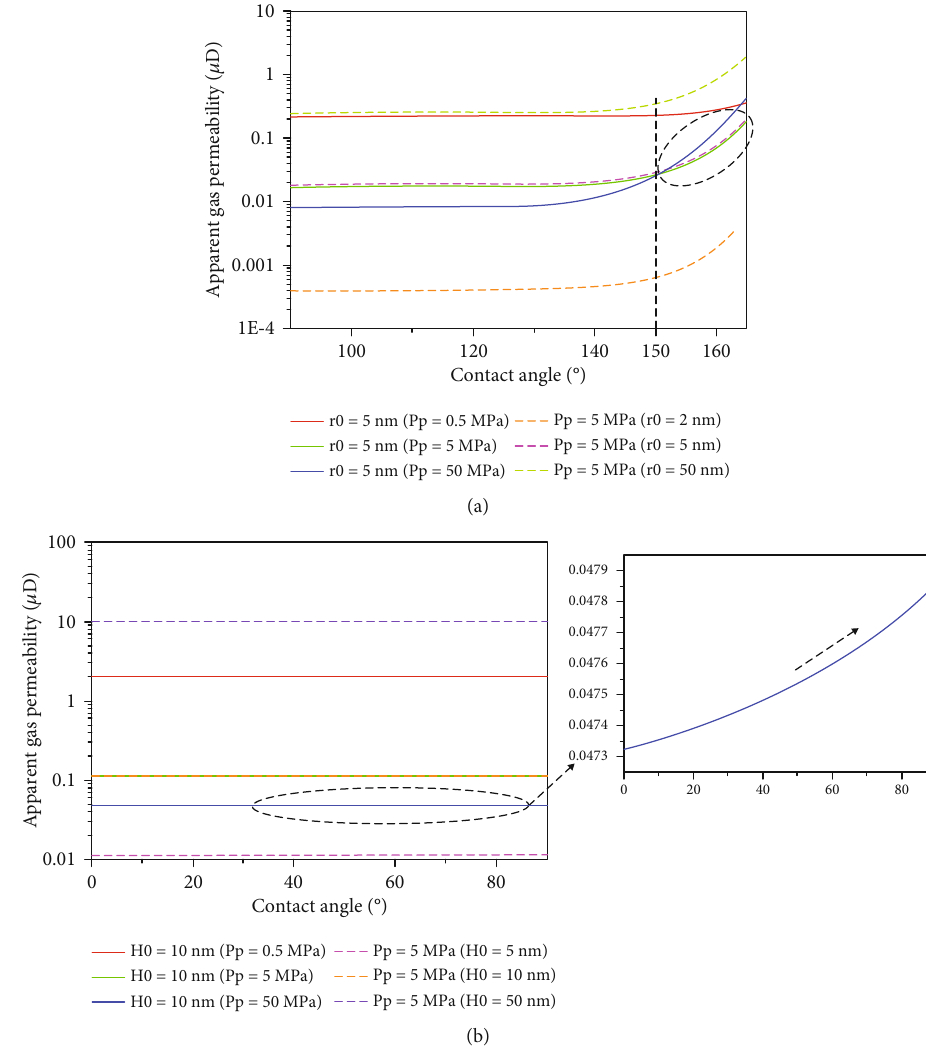
Figure 9: The coupled impacts of pore size, pore pressure, and contact angle on gas fl ow in (a) OM and (b)